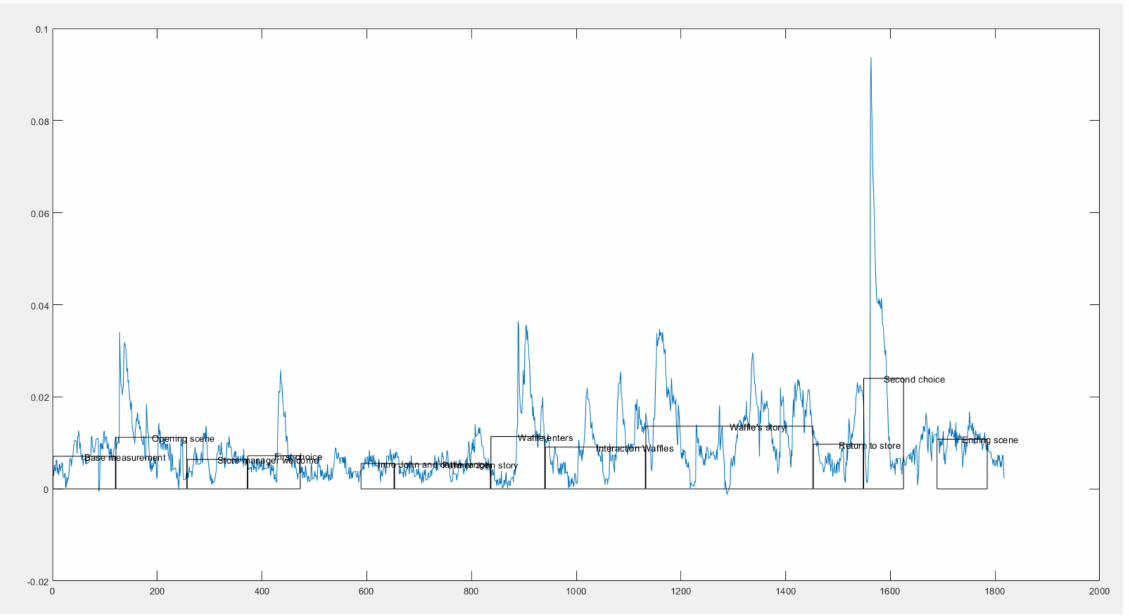
Figure 4. Illustration of the GSR data